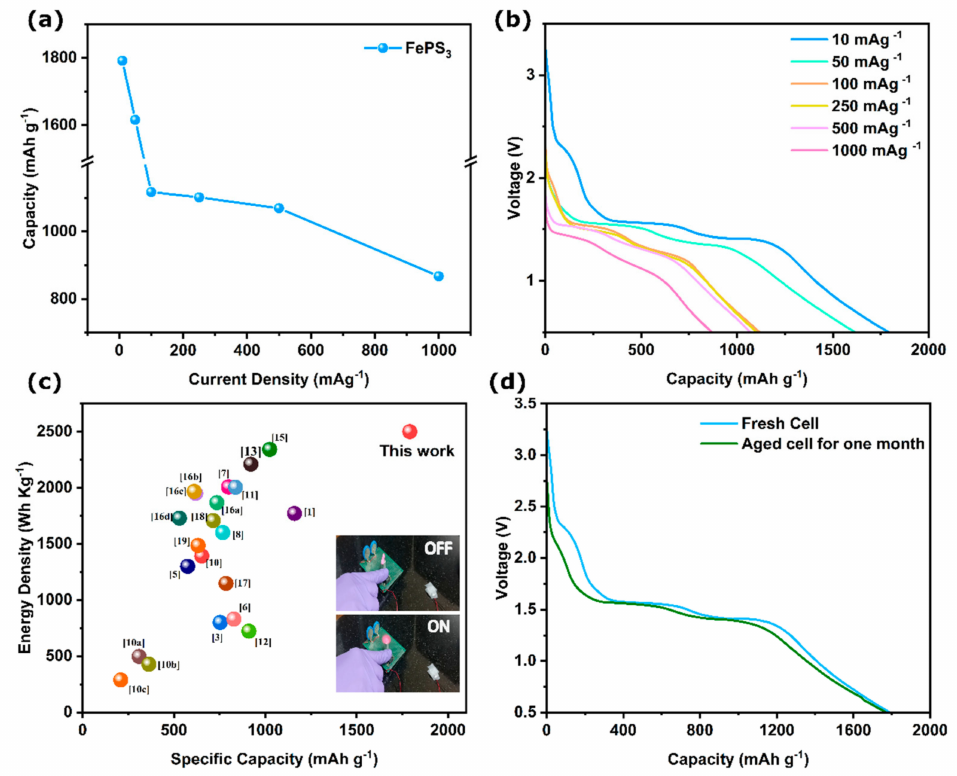
Figure 5. ( a ) Galvanostatic full-discharge profiles and ( b ) rate capability of FePS 3 primary battery at various current densities. ( c ) Comparison analysis graph of reported batteries with this work with the photographic images of FePS 3 -based primary cell (battery) running a small motor (1.2 V/15 mA) as inset. ( d ) Shelf-life study of the battery tested one month after assembling, where the cells are discharged at 10 mA g − 1